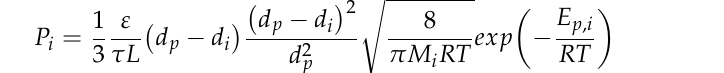
Figure 15. Cross-sectional morphologies of ( a ) CL-AAA- and ( b ) NC-AAA-derived membranes obtained via field-emission scanning electron microscopy (FE-SEM; 300,000 × magnification) and transmission electron microscopy (TEM; 30,000 × magnification) images of deposited ( c ) CL-AAA- and ( d ) NC-AAA-derived films. SEM and TEM images were adapted from [93]. The microstructural properties of the NC-AAA and CL-AAA membranes were an- alyzed by estimating their mean pore diameters at different temperatures by using the modified gas translational model. The modified gas translation model proposed by Lee et al. [98] presents a way to estimate a mean pore size of <1 nm for membranes by em- ploying a normalized Knudsen permeance (NKP) method. In formulating the equation for microporous molecular-sieving membranes, the membrane configurational parameters such as porosity, tortuosity, thickness and mean pore diameter should be considered. How- ever, for simplicity, the permeating molecules are assumed to permeate through cylindrical channels, and the proposed modified gas translational model is given in Equation (3)